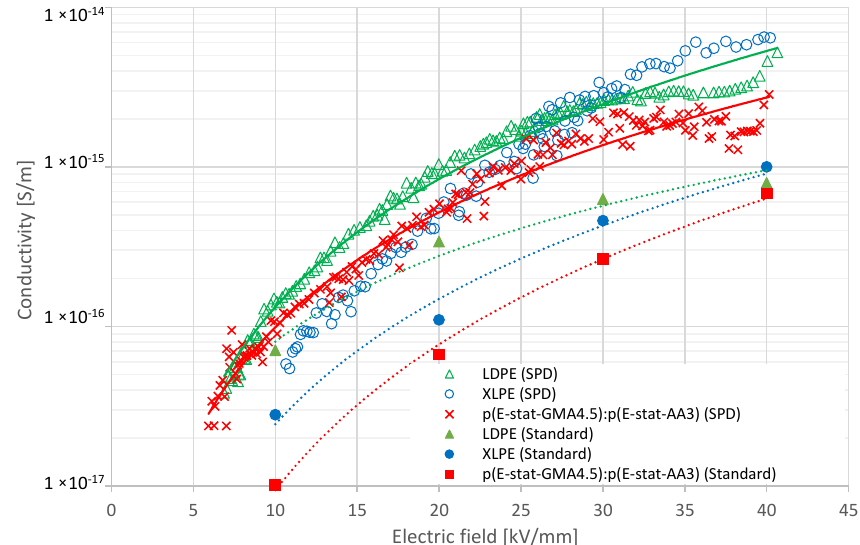
Figure 9. Field dependent apparent conductivity evaluated from surface potential decay (SPD) measurements conducted at room temperature; average DC conductivities presented in Section 4.2 for 30 °C (standard) are also shown.